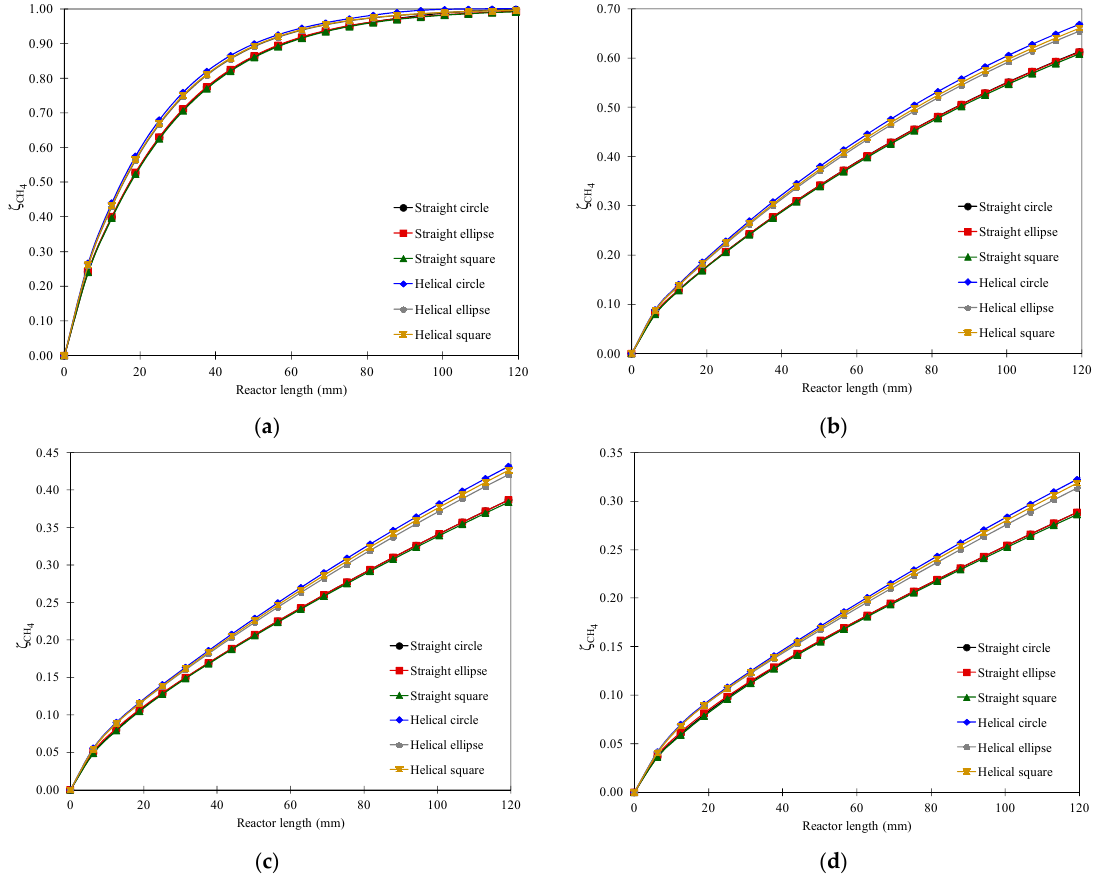
Figure 7. Methane conversion along the straight and helical reactor at Reynolds numbers of ( a ) 100, ( b ) 500, ( c ) 1000, and ( d ) 1500.